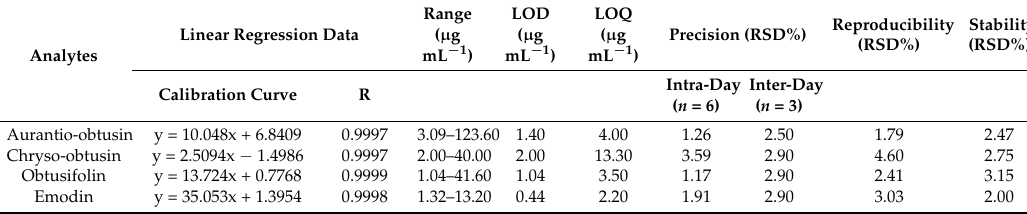
Table 1. Linear regression data, limit of detection (LOD), limit of quantitation (LOQ), precision, reproducibility and stability of the entire analytical method.